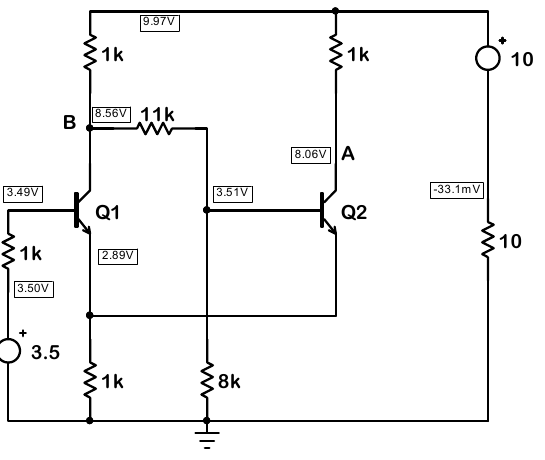
Figure 1. Schmitt trigger and the results of default DC analysis in IsSpice4